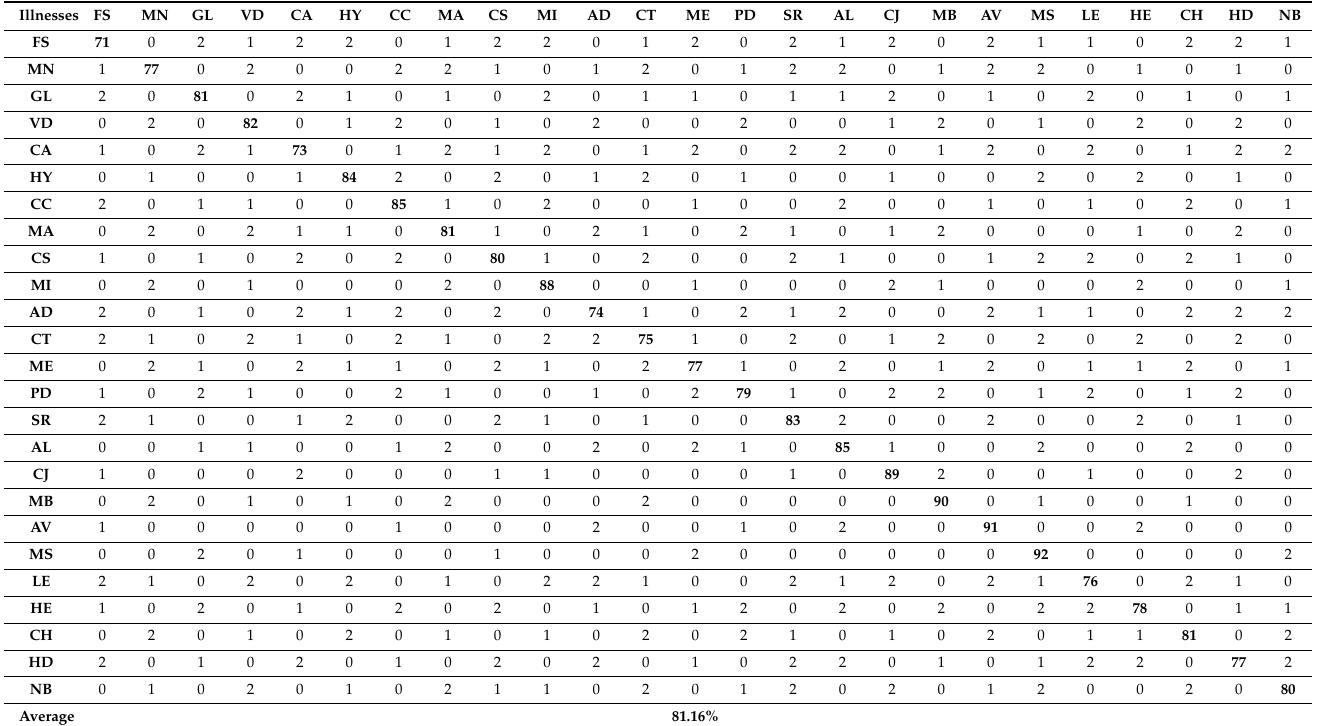
Table 8. Performance of Independent Component Analysis (ICA) method (instead of using the developed approach) using MRI dataset (Unit